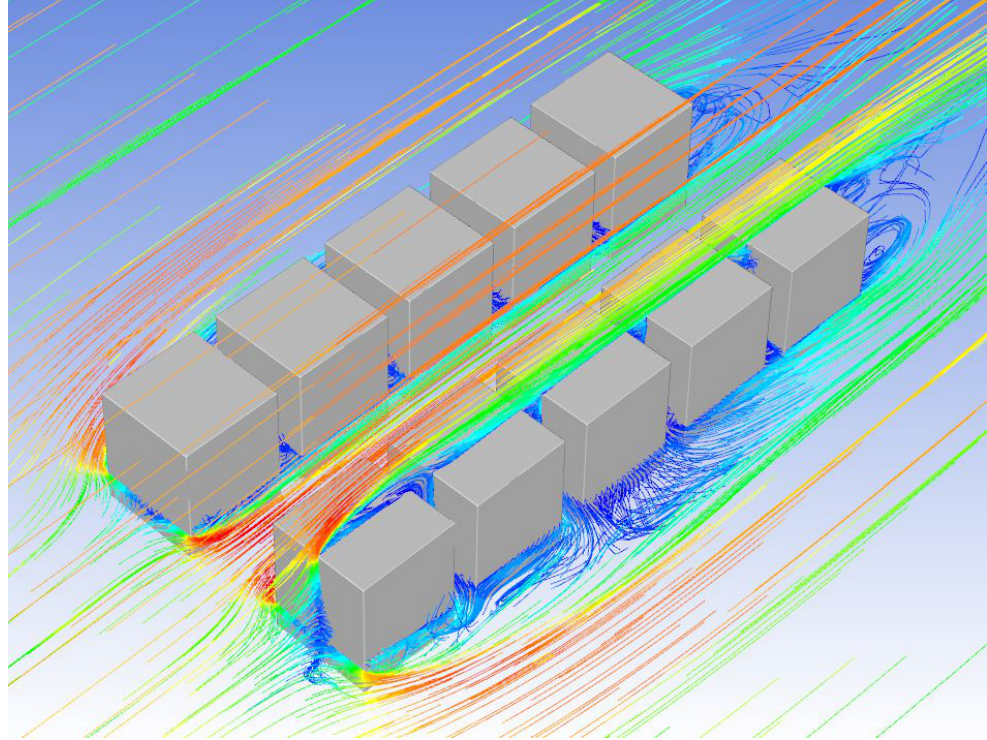
Figure 1. Streamlines representing air flow around buildings: change in colours represents the variation in magnitude intensity of air